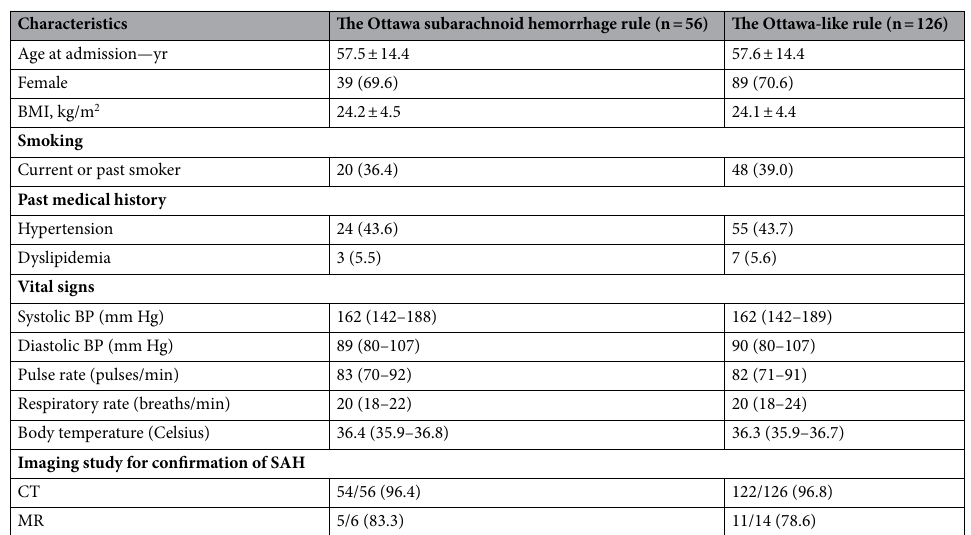
Table 2. Demographic characteristics of patients with subarachnoid hemorrhage. Reported count (proportion) for categorical variables and median (interquartile range) or mean ± standard deviation (SD) for continuous variables, where appropriate. Lumbar puncture was applied in two patients, and both of them presented with xanthochromia. In the cohort of the Ottawa-like rule, xanthochromia confirmed SAH in one patient with negative imaging results. Missing (Ottawa subarachnoid hemorrhage rule): Smoking history = 1; Diastolic BP = 1; Pulse rate = 9; Respiratory rate = 7; Body temperature = 15. Missing (Ottawa-like rule): BMI = 1; smoking history = 3; diastolic BP = 1; pulse rate = 2; respiratory rate = 19; body temperature = 38. BMI, body mass index; BP, blood pressure; CT, computed tomography; GCS, Glasgow coma scale; MR, magnetic resonance; SAH, subarachnoid